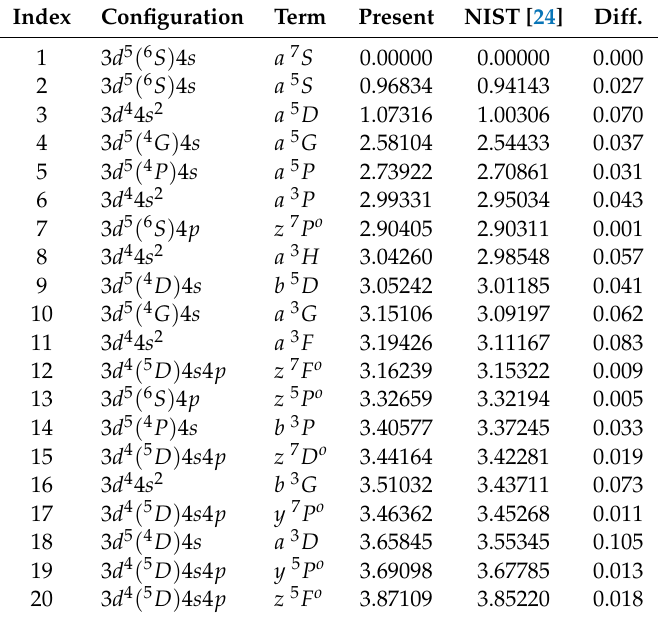
Table 1. Excitation energies (in eV) of the Cr I target levels included in the present photoionization